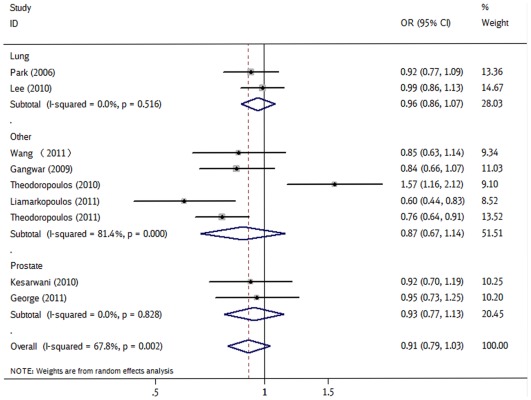
Forest plot of cancer risk associated with rs4645978 under allele contrast in different types of cancers.The squares and horizontal lines correspond to the study-specific OR and 95% CI. The area of the squares reflects the study specific weight (inverse of the variance). The diamond represents the pooled OR and 95% CI.